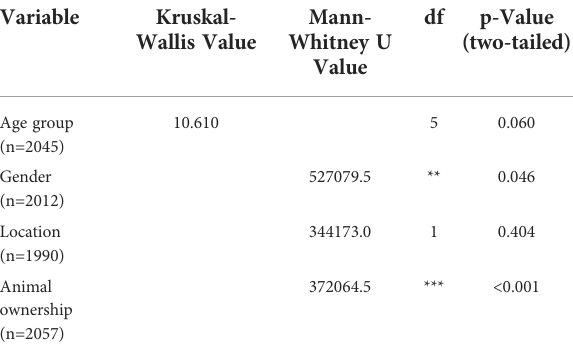
TABLE 1 Association between demographic variables and reporting con fi dence.